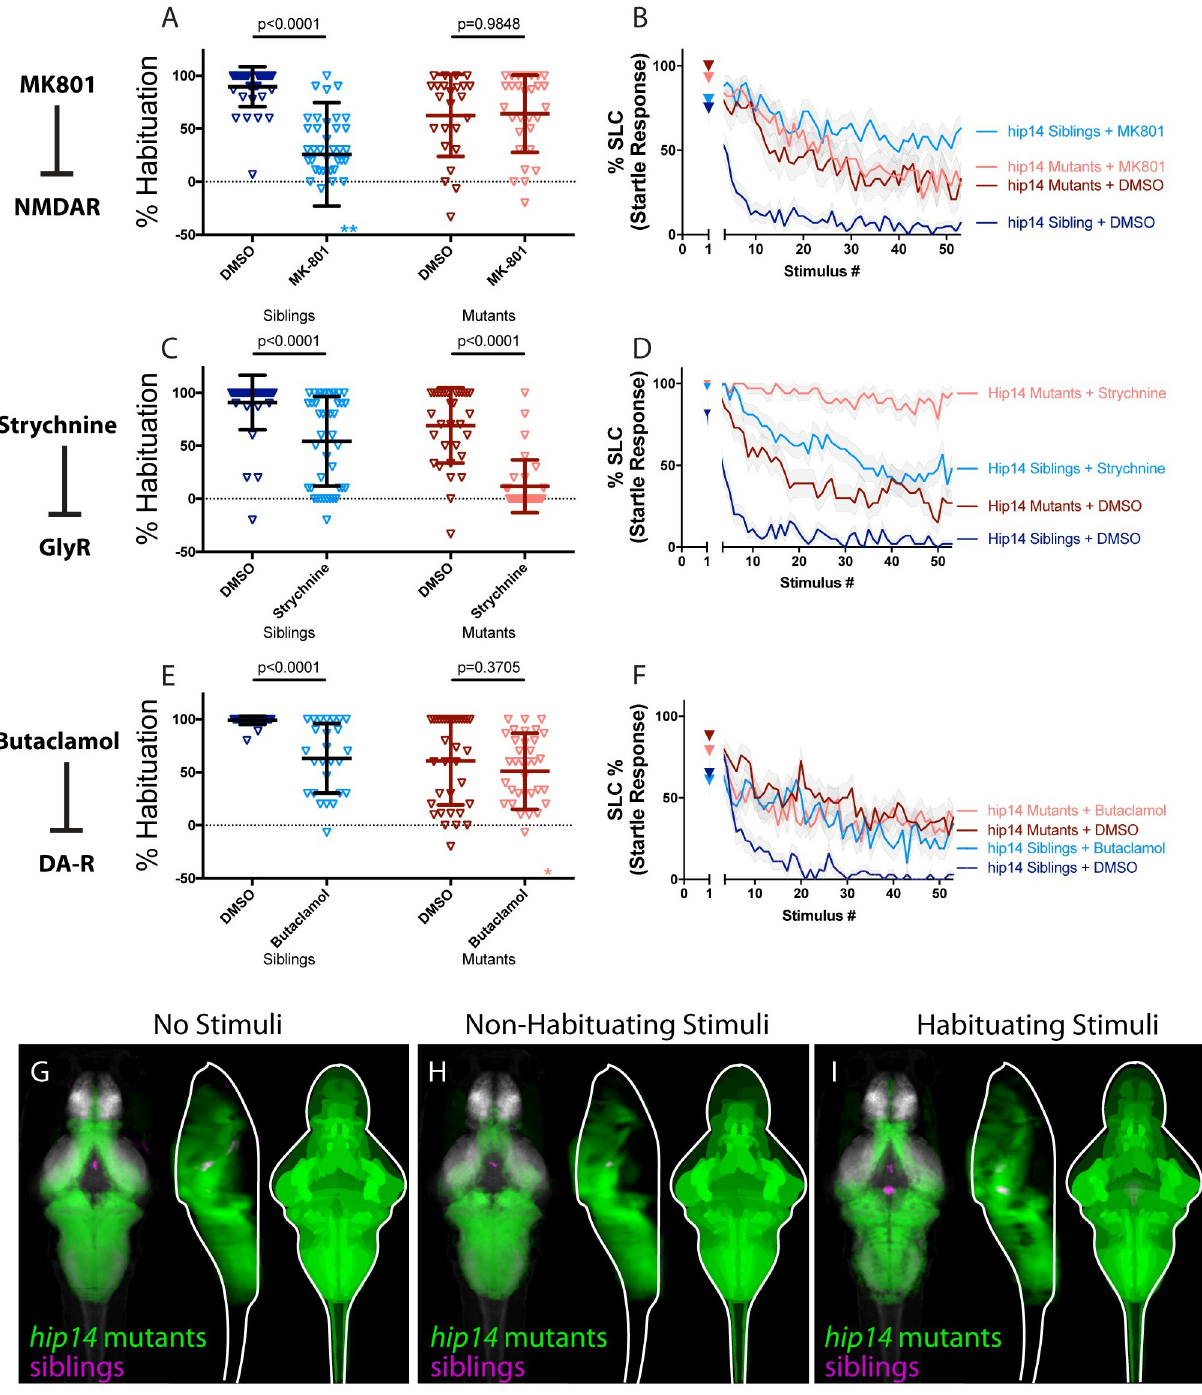
Fig 2. Hip14 acts through NMDA and dopamine signaling and produces broad hyperactivity of neuronal circuits. (A-B) MK-801 impairs habituation learning in siblings, (p < 0.0001 Sidak’s test for multiple comparisons, n = 38 DMSO, n = 38 MK-801), but does not enhance habituation learning deficits observed in hip14 mutant larvae (p = 0.9848, n = 24 DMSO, n = 29 MK-801, p < 0.0001 indicates significant interaction between drug treatment and genotype; these and all subsequent statistical analyses use Two-way ANOVA with Sidak’s multiple comparisons test unless otherwise indicated). ** indicate sibling+MK801 individuals with % hab values below y-axis limit at -100% and -180%. (C-D) Strychnine significantly enhances habituation learning deficits observed in hip14 mutant larvae, indicating that glycine signaling and hip14 may act within parallel molecular or circuit pathways to regulate habituation learning (p < 0.0001, n = 40 DMSO-siblings, n = 42 Strychnine-siblings, n = 32 DMSO-mutants, n = 32 Strychnine-mutants, p = 0.0639